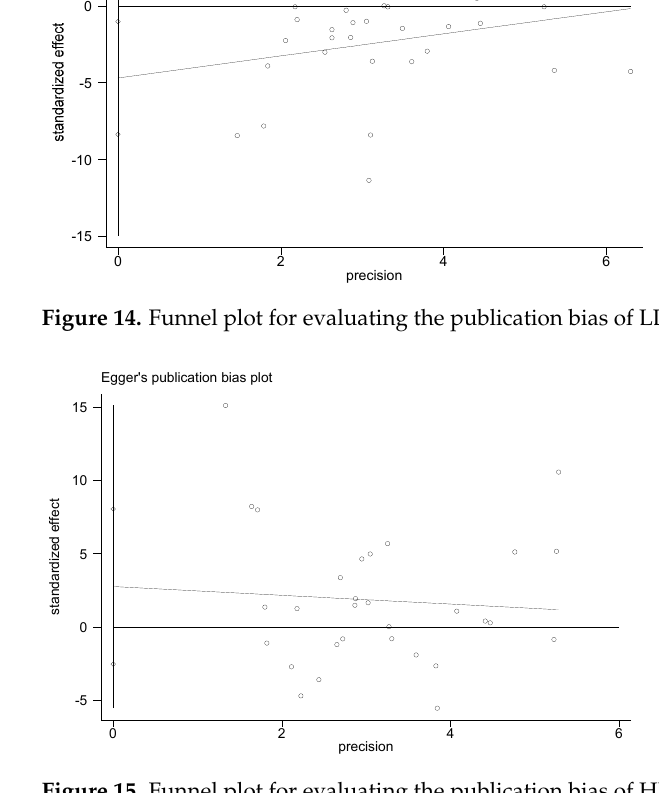
Figure 15. Funnel plot for evaluating the publication bias of HDL − C.